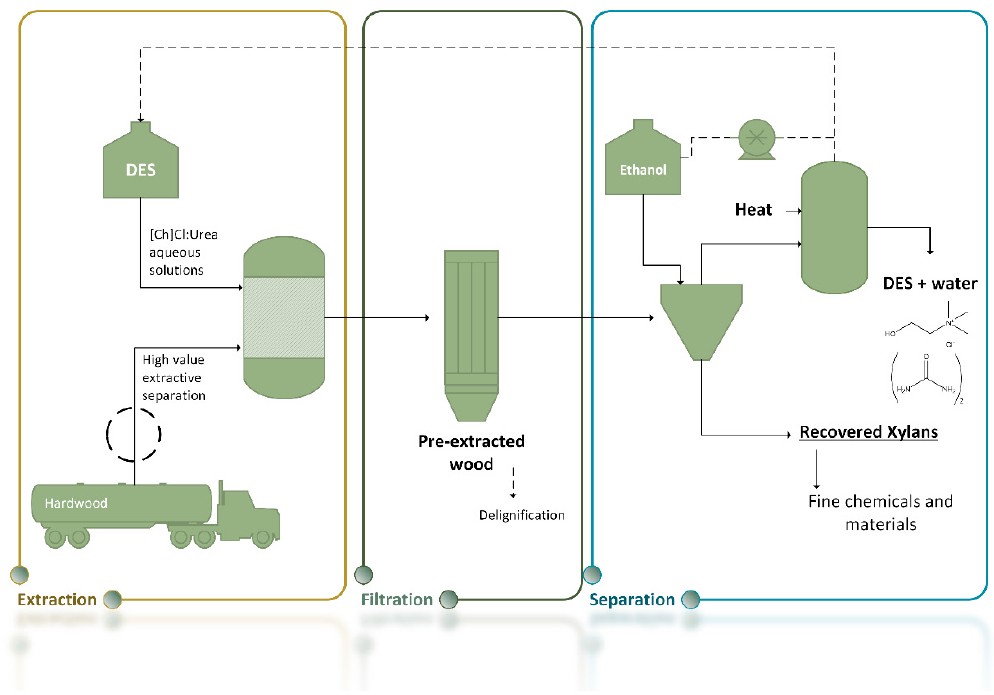
Figure 8. Schematic representation depicting an integrated process within biorefinery using [Ch]Cl:U aqueous solutions to extract xylans from hardwood (adapted from [238]).